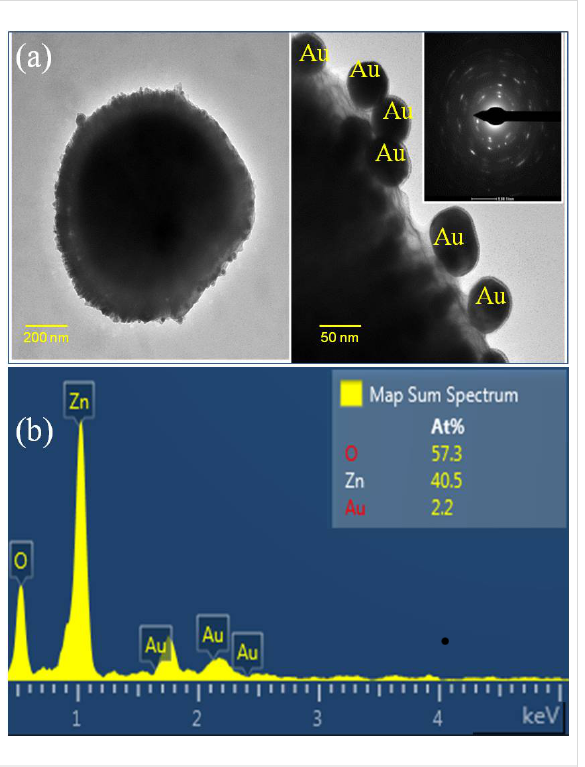
sphere is assembled from numerous nanorods pointing toward the center of the microsphere.